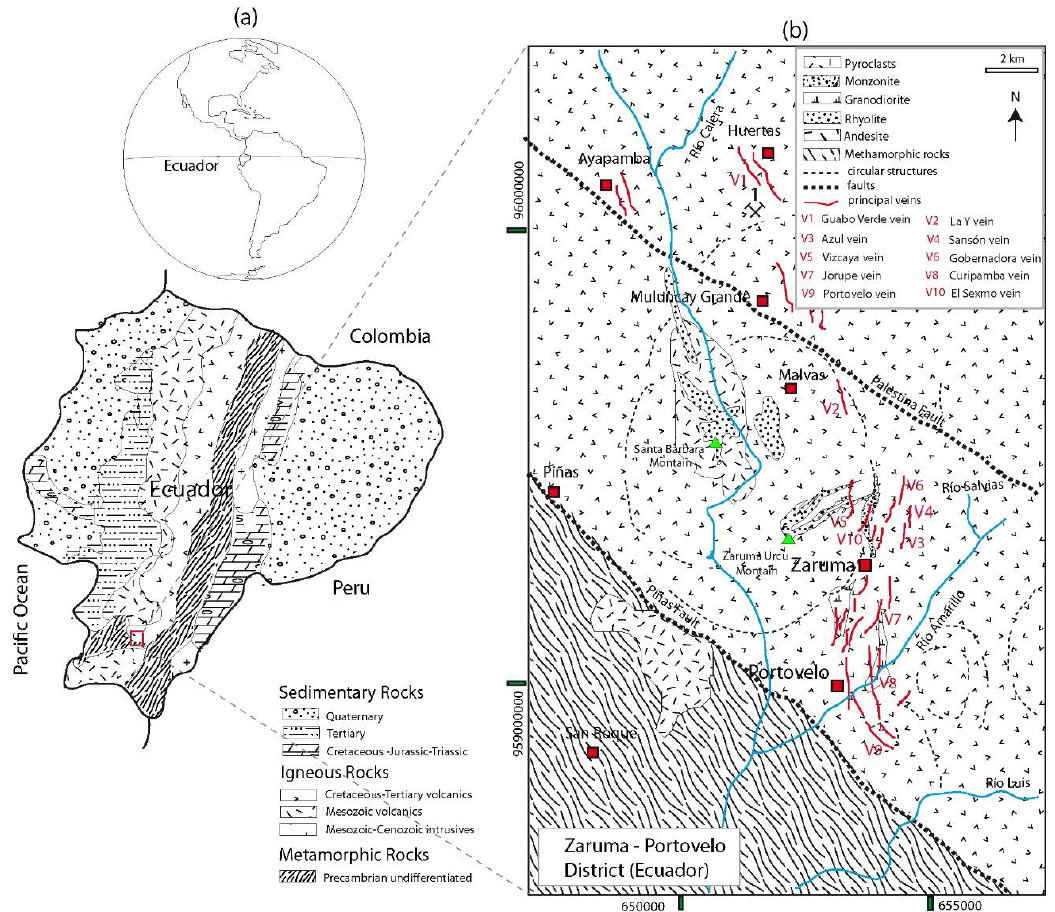
Figure 2. ( a ) Simplified geological map of Ecuador and location of selected area; and ( b ) geological map of Zaruma-Portovelo gold field with basic geology (volcanic and intrusive rocks), principal structures and most important veins. Modified from [ 28 ] with data from [ 30 ] .